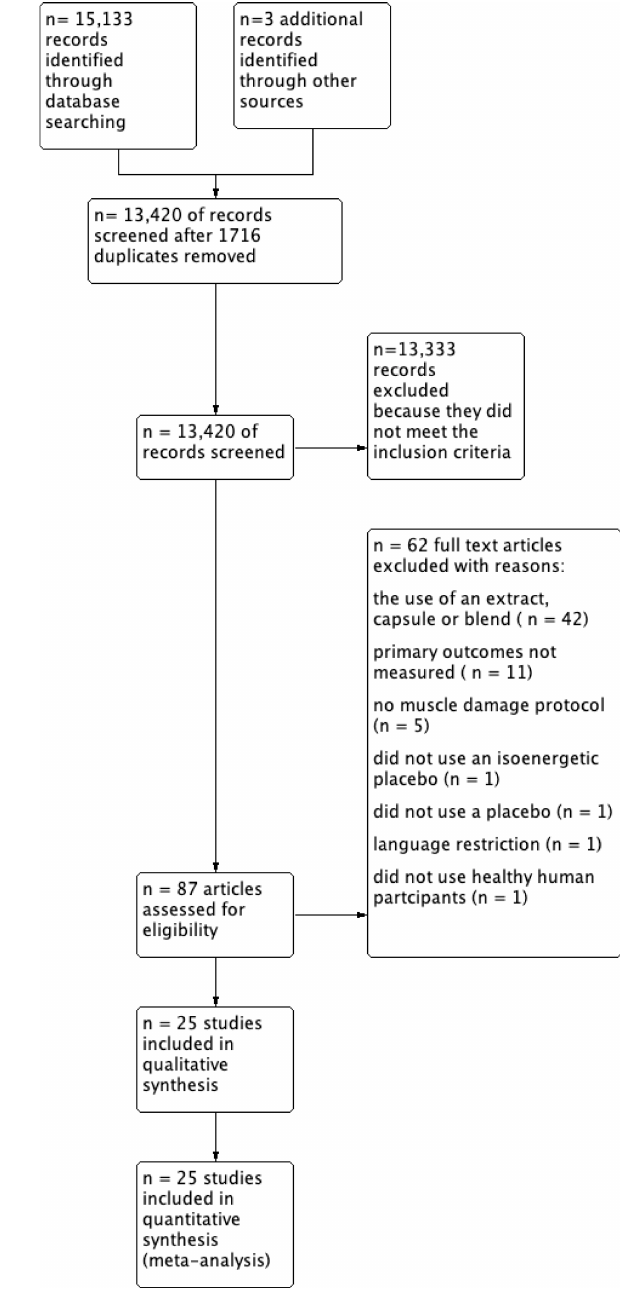
Figure 1. Study Flow Diagram.